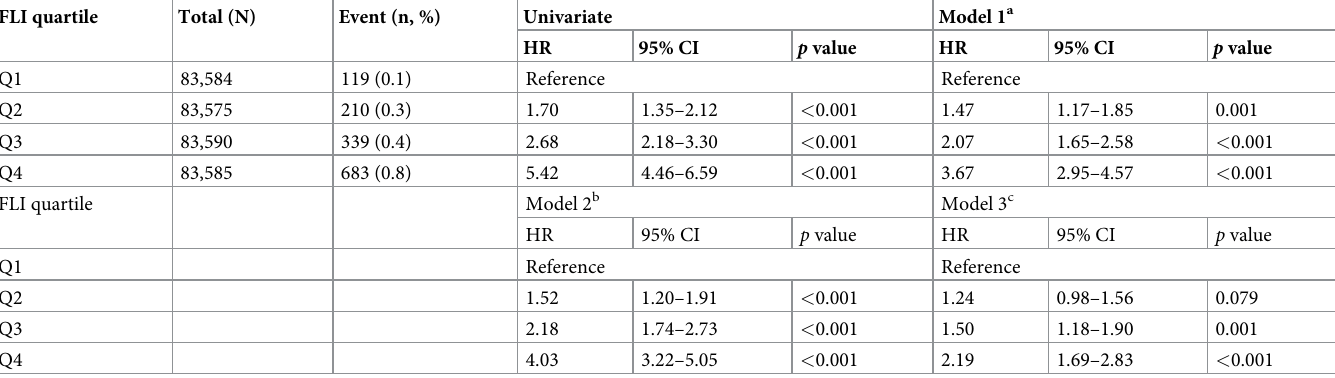
Table 2. Association between fatty liver index and new-onset sleep